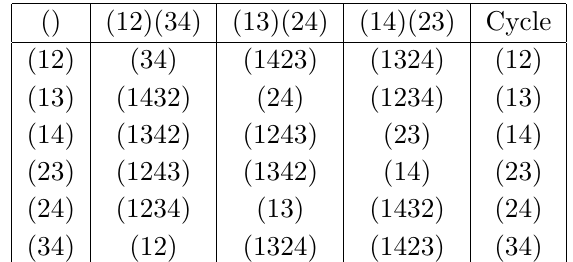
Table 8 . Right multiplication of fV